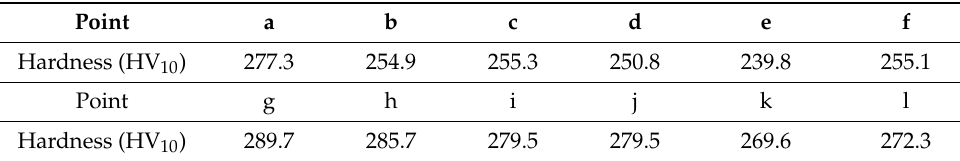
Table 5. Hardness value.